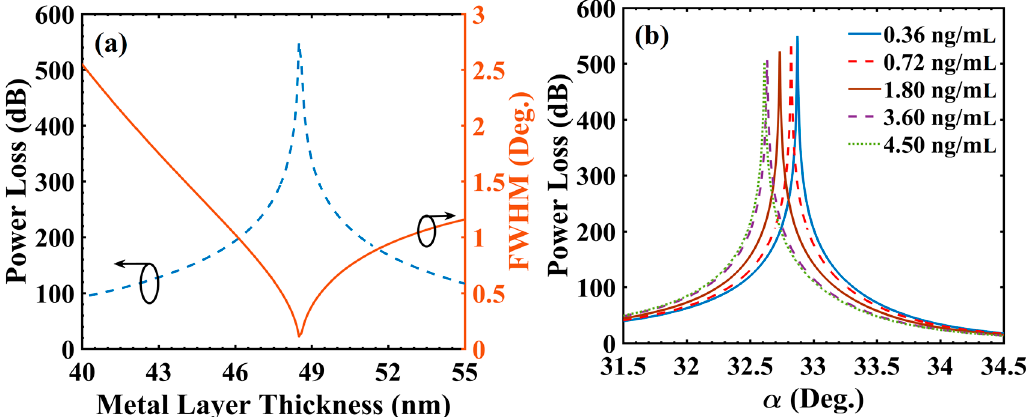
Figure 6. ( a ) Variation of power loss (in dB) and FWHM with metal layer thickness for C C = 0.36 ng/mL) and ( b ) power loss variation with incident angle for different concentration of cortisol (in solution of cortisol ‐ conjugated BSA); d 1 /d = 0.5 (SiO 2 gratings), t Ag = 48.50 nm and λ = 830 nm.